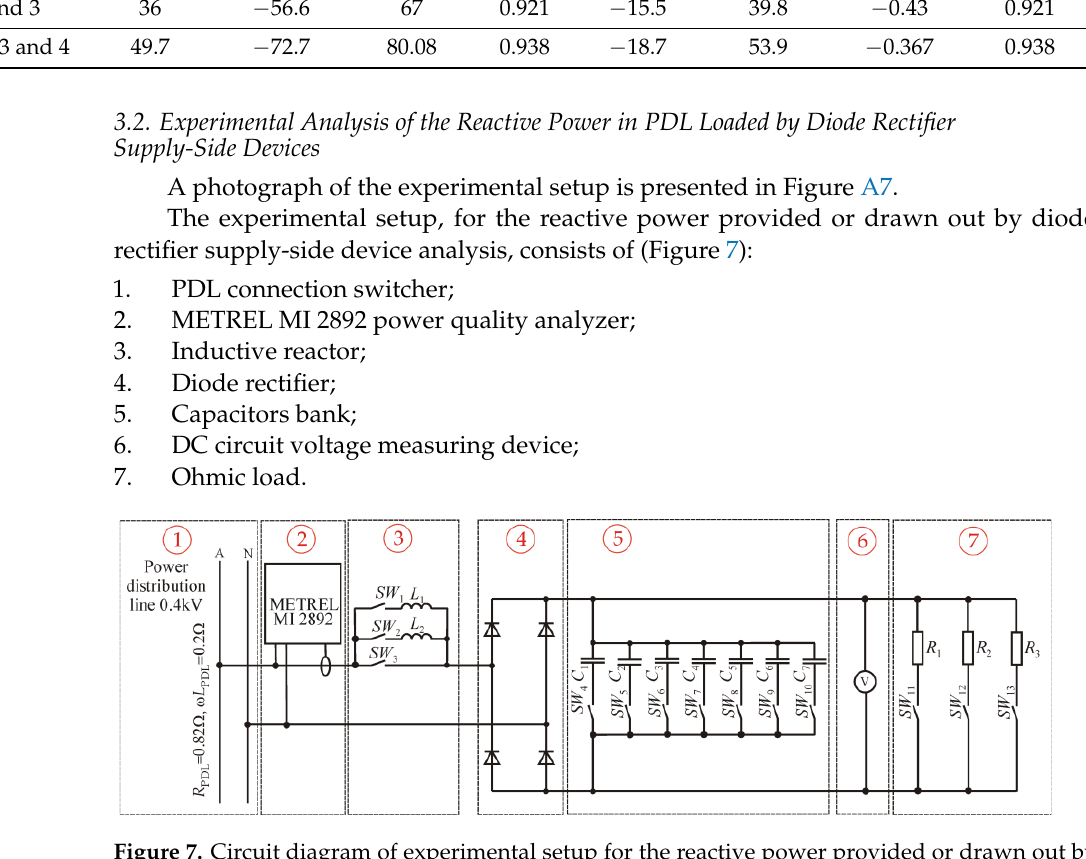
Figure 9. tg ϕ at the point of connection of the single-phase diode rectifier supply-side device to the PDL as a function of DC circuit capacity value, in case of internal parameters of PDL-connected R PDL = 0.82 Ω, ω L PDL = 0.2 Ω. The next step of the experiment was performed by keeping the power constant of the single-phase diode rectifier supply-side device and connecting additional inductive